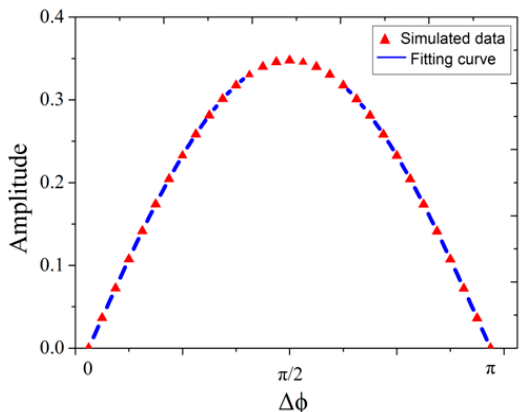
Figure 4. Relationship between the amplitude of the output fundamental voltage and ∆ φ . The red scatter points represent the simulative values, and the blue curve is the corresponding fitting curve.